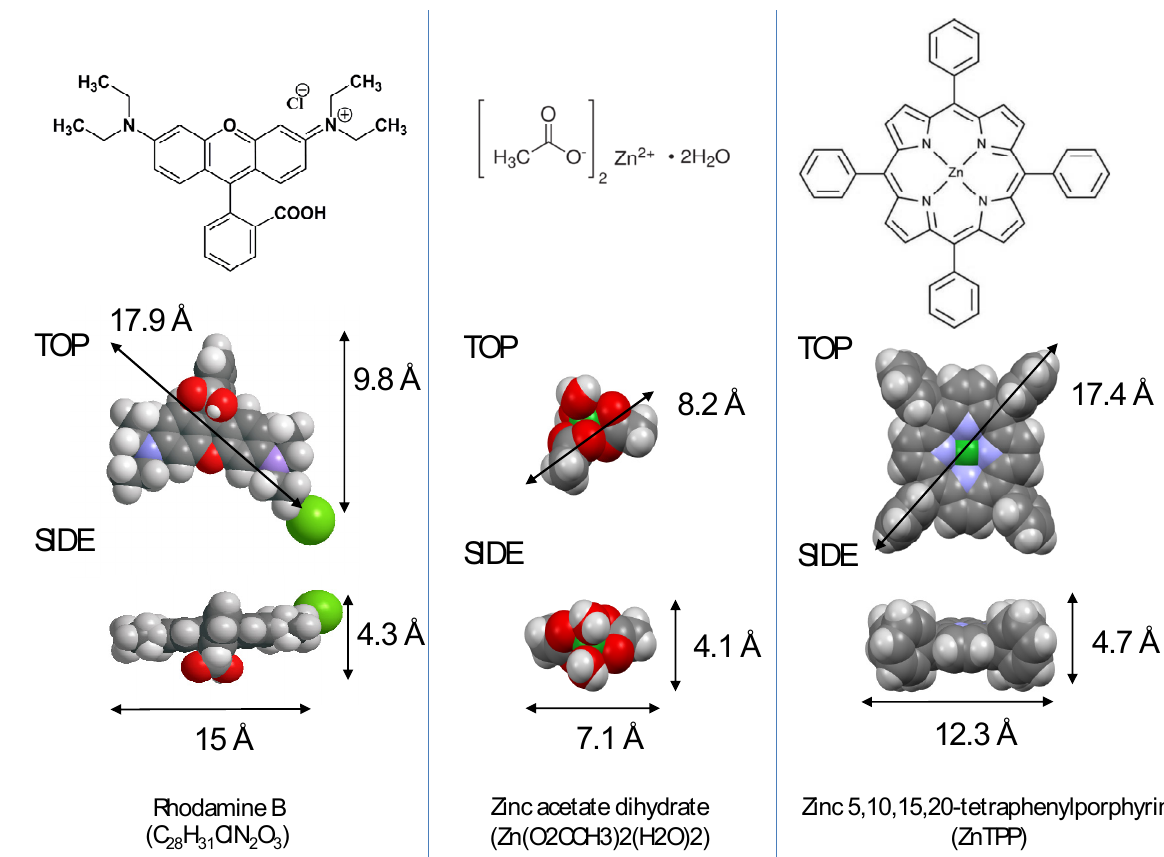
Figure 2. The formulas, schematic and space filling structures, as well as dimensions of each of the three molecules used in this work. The Cl − anion of Rhodamine B is free in solution and may be displaced by the negatively charged water at a silica-water interface.